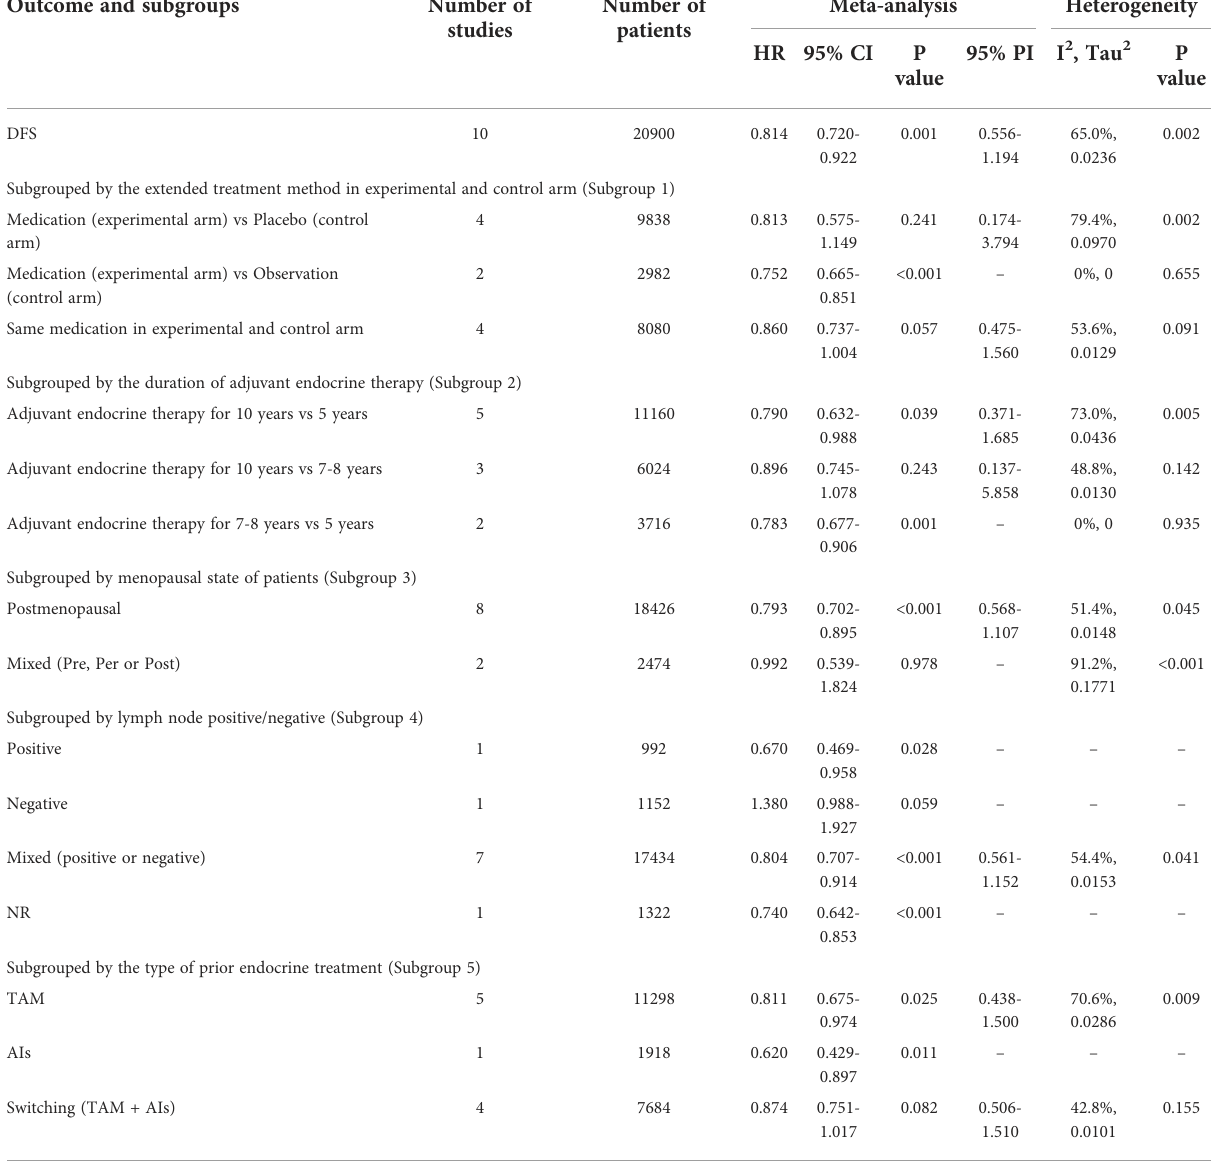
TABLE 2 Meta-analysis of DFS for extended versus routinely endocrine treatment in HR+ early breast